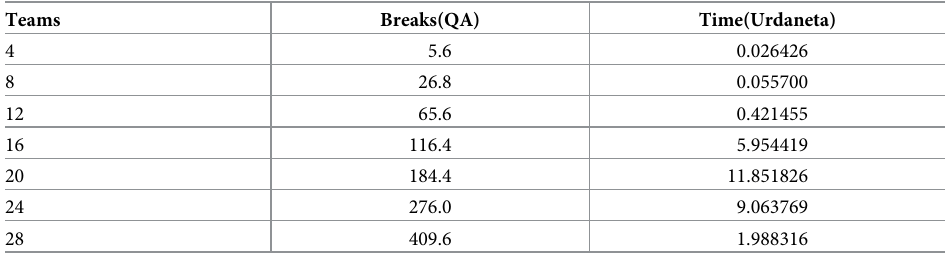
Table 9. QA vs. IP(Urdaneta) in DRRTs.